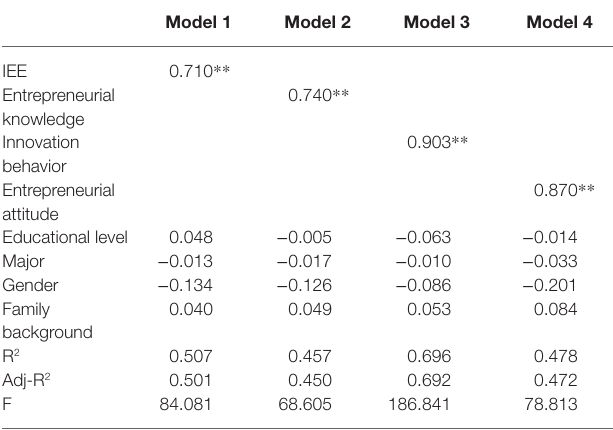
TABLE 10 | Robustness test of add independent variable (dependent variable: Entrepreneurial